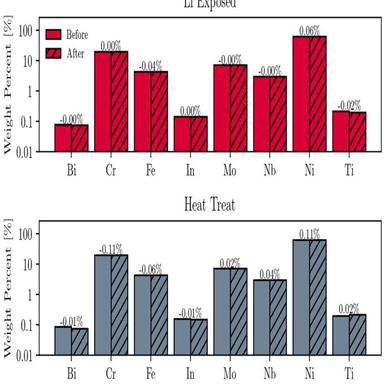
XRF chemical compositions before and after lithium exposure. Like the EDS results, the XRF scans show no change in the composition of the Inconel samples. In this case, the heat-treated sample actually have more variation than the lithium exposed samples. The height of the bars represents the average composition of samples S1-S3. The text above the bars represents the change in chemical composition after lithium exposure.